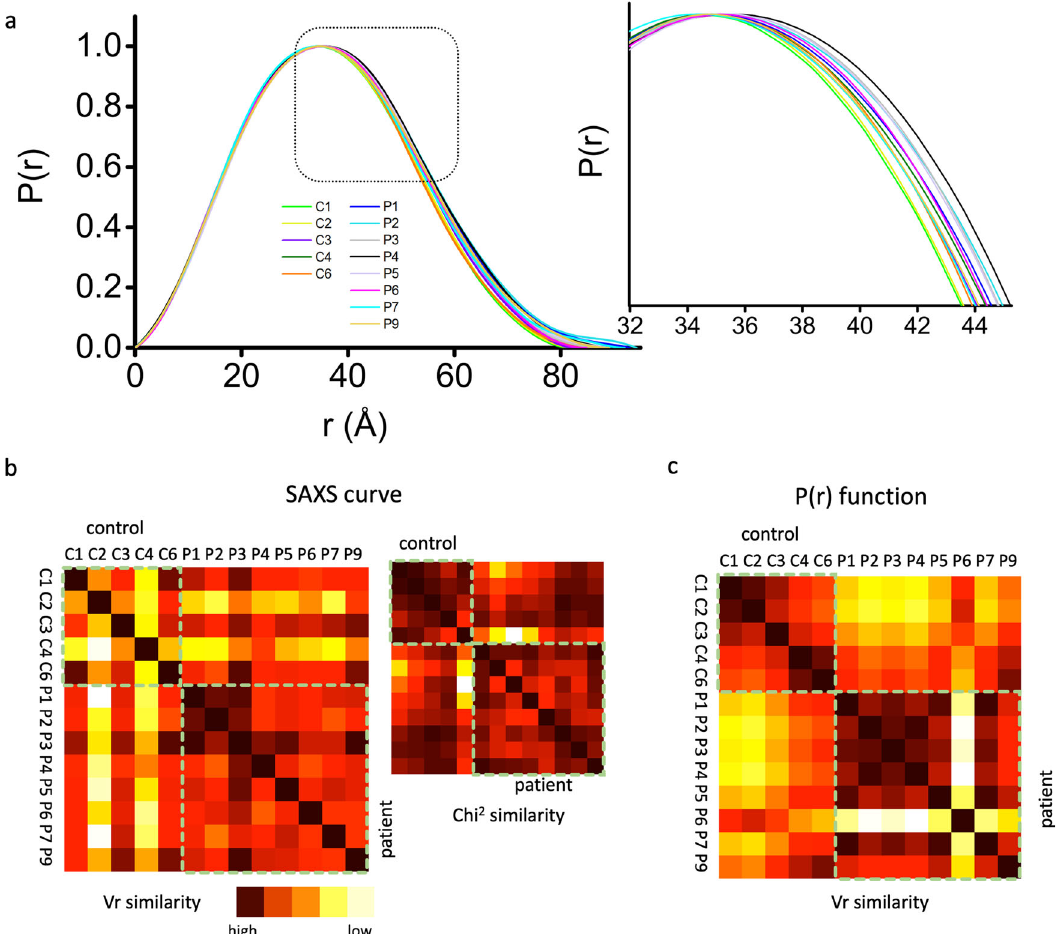
Fig. 2 Broadening of P ( r ) functions correlate between patient and control samples. a P ( r ) functions and zoom-in section show the shift in P ( r ) maxima and distinct broadening for patient samples. b A measure of structural similarity between SAXS curves scored by the volatility of ratio ( Vr ) and Chi 2 shown in the inset. c A measure of structural similarity between P ( r ) functions scored by the volatility of ratio ( Vr ). Scores were assigned a gradient color with a red-high agreement and white-low